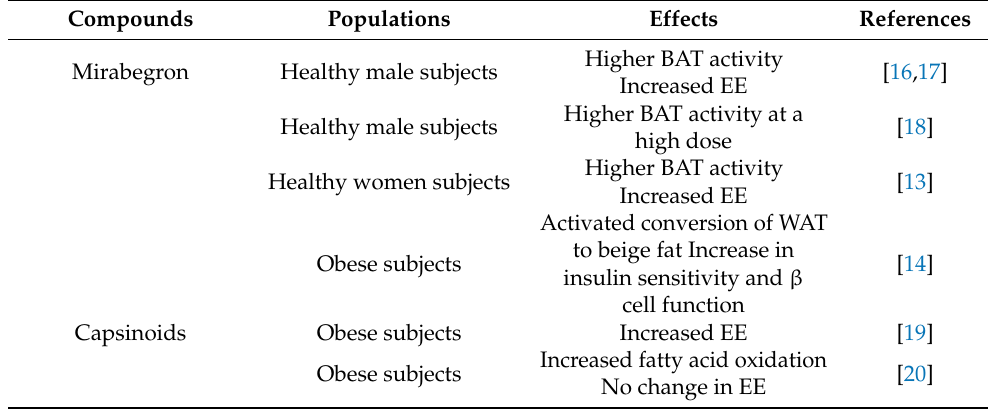
Table 1. Activation of thermogenic adipocytes by pharmacological therapies.